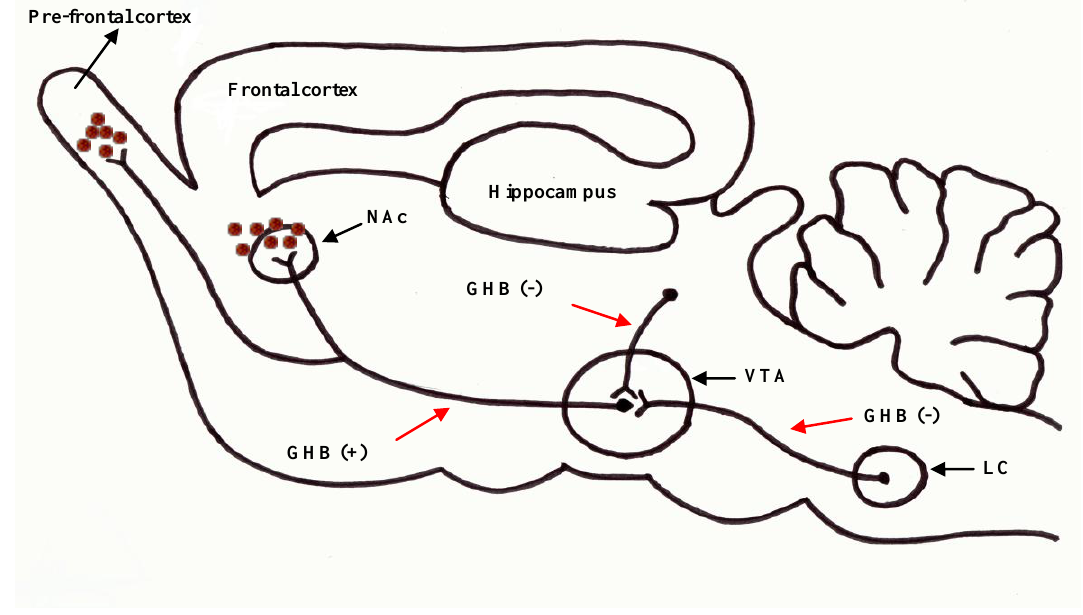
“-“: inhibition; “+” : activation; : dopamine (a) dopaminergic neurons (DA) originate from ventral tegmental area (VTA) and project